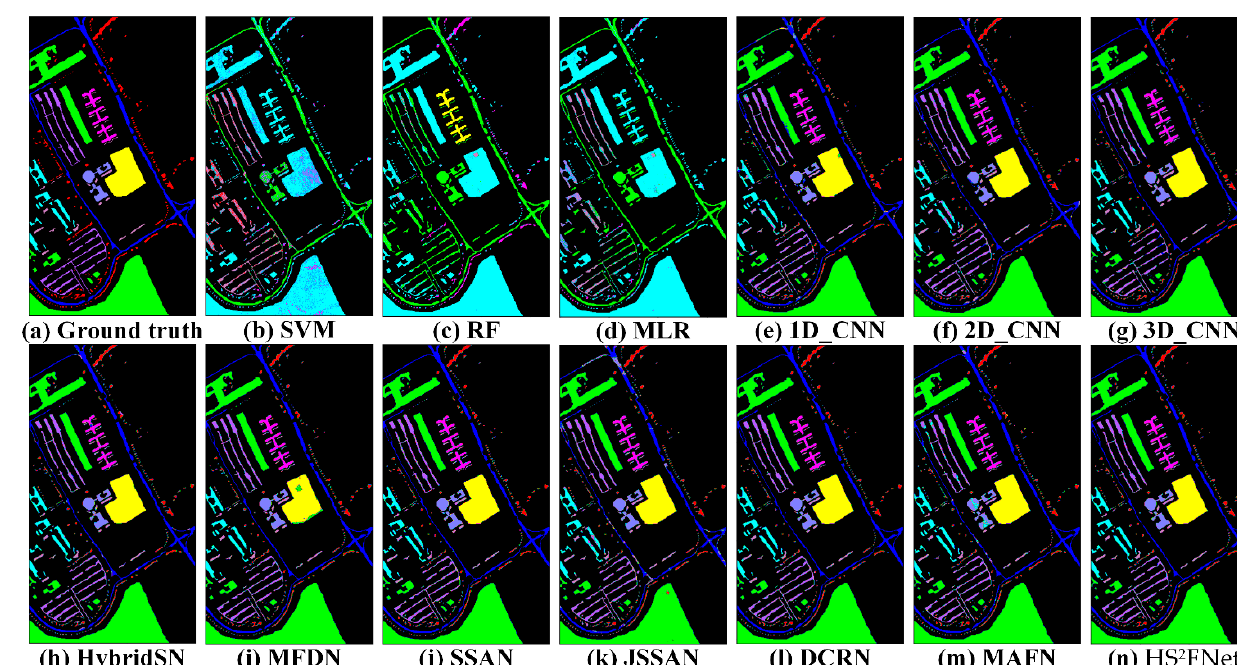
Figure 10. The visual comparisons of the state-of-the-art models and our network on UP dataset.